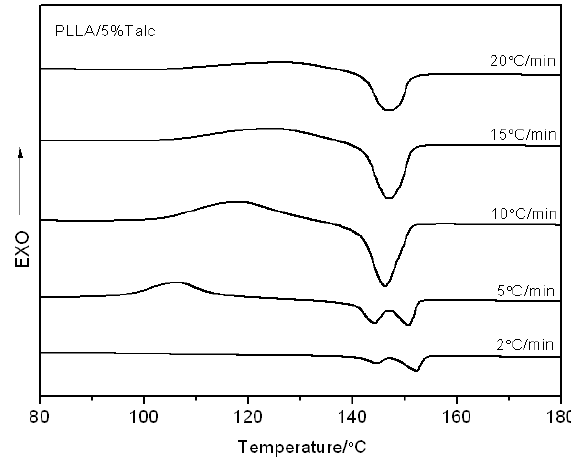
Figure 2. Melting behavior of PLLA/5%talc composites at a different heating rate during non-isothermal crystallization at different cooling